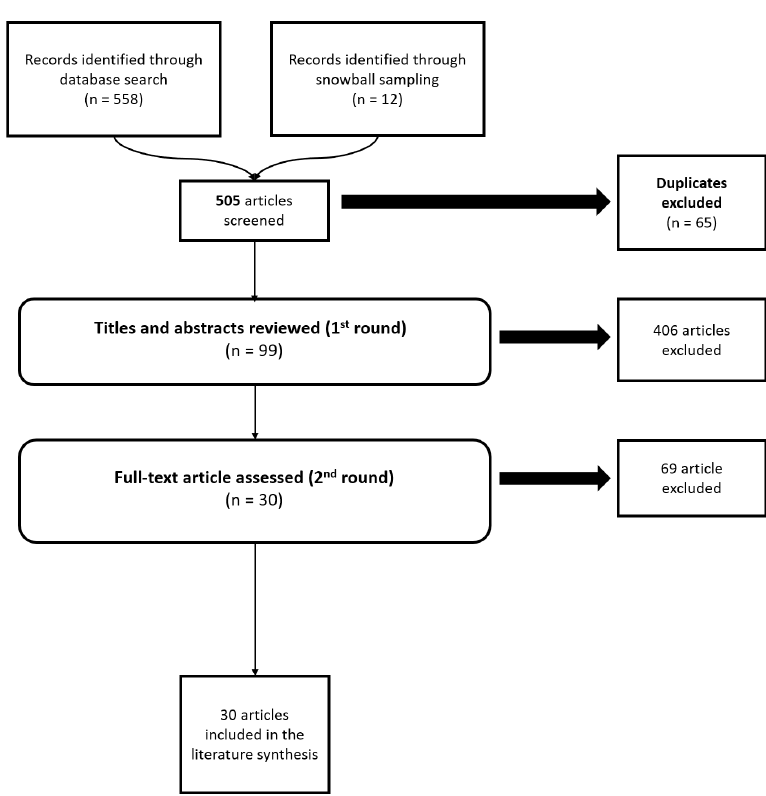
A PRISMA Diagram of the Data Collection